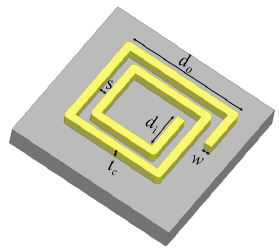
Figure 2. Physical parameters of a square-shaped printed spiral coil.